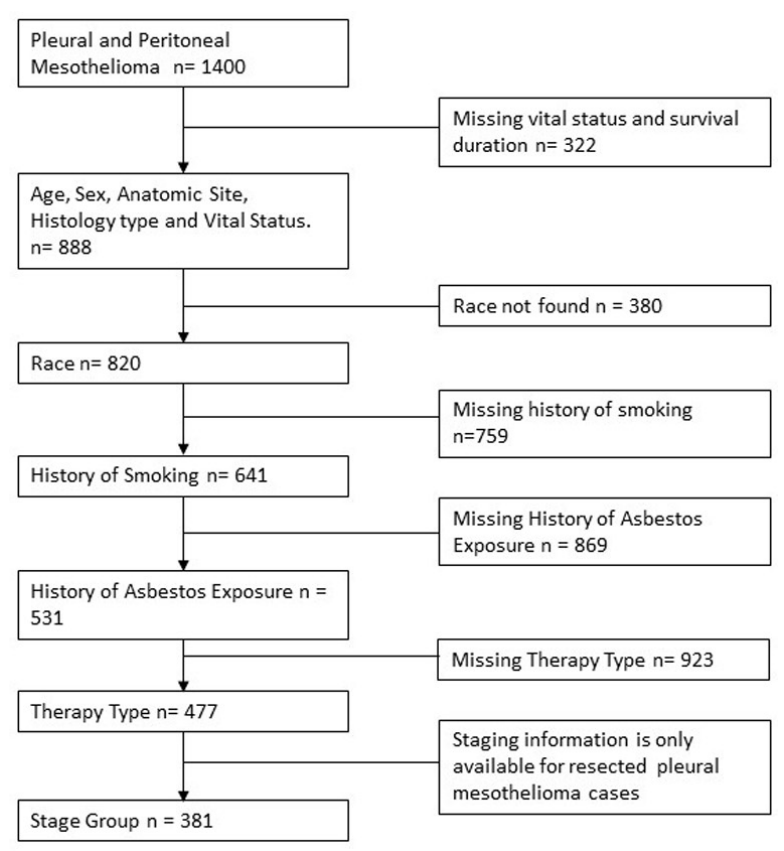
Figure 1. Study workflow and case inclusion and exclusion